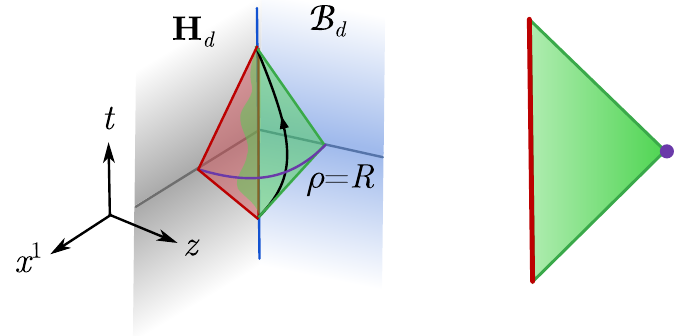
Figure 2. Left . The bulk causal domain ~ D [ B + ] (green), cut away to reveal the boundary causal domain D [ B + ] (red). The minimal surface is purple. Right . The Penrose diagram for the hyperbolic black hole. The minimal surface and bifurcation surface (purple)